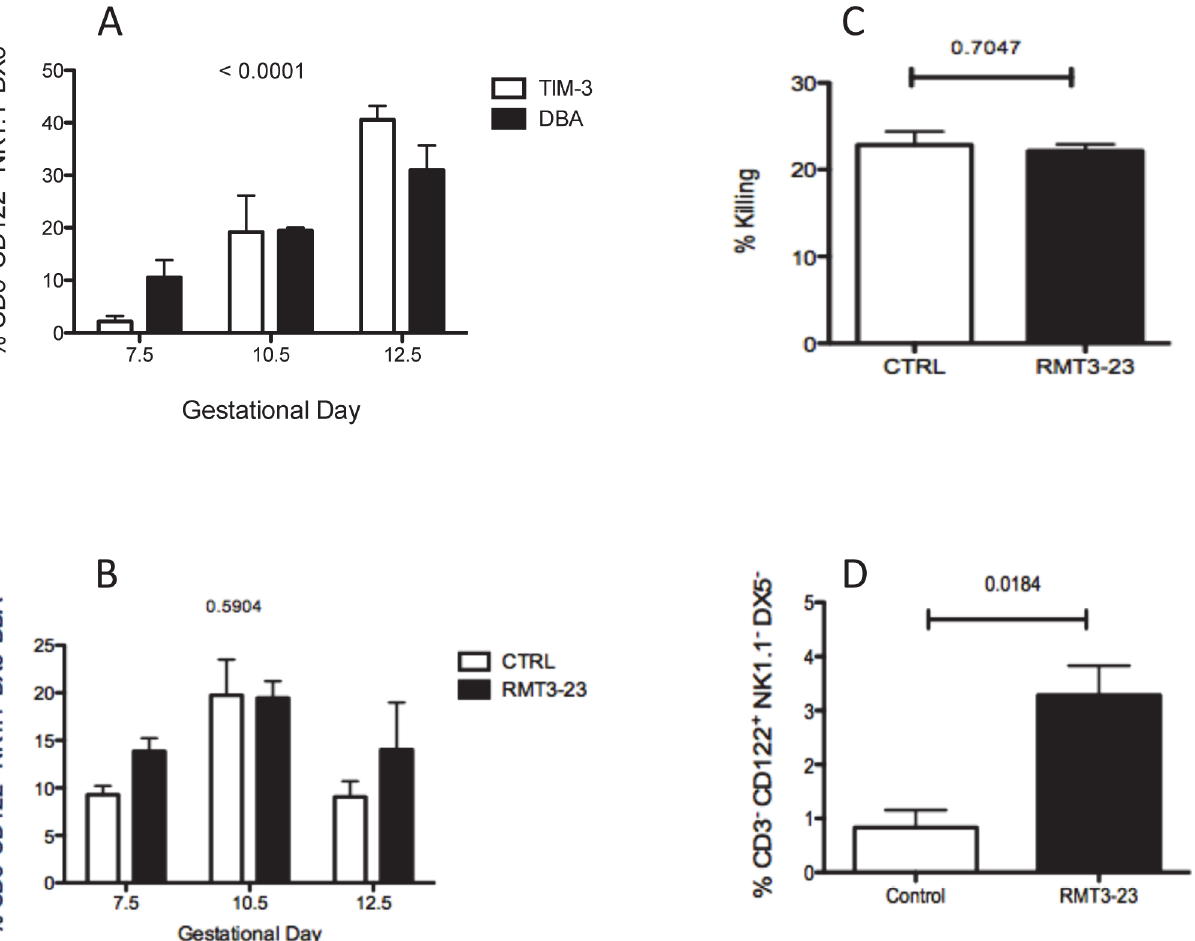
Fig 3. A. Expression of TIM-3 and DBA on uNK cells during gestation. A steady and similar increase in the expression of both TIM-3 and DBA is observed between GD 7.5 and 12.5, the time period when the uNK cells are most abundant in the uterus. TIM-3 and DBA expression were determined on the CD3 - CD122 + NK1.1 - DX5 - cells isolated from the uterus of pregnant CBA mice allogeneically mated with C57BL/6 males (n = 8). Data are presented as mean ± SEM and are representative of at least 3 experiments. Data show the percentage of CD3- CD122+ NK1.1- DX5- cells expressing DBA and TIM-3 on different GDs. Statistical analysis was performed using 2 way ANOVA. B. Effect of TIM-3 blockade on uNK cell population size. Percentage of CD3 - CD122 + NK1.1 - and DX5 - cell population in control and RMT3-23 treated pregnant CBA mice at GD 7.5, 10.5 and 12.5. There was no significant change in the number of uNK cells between control and treated groups. Data are presented as mean ± SEM and are representative of at least 3 experiments. Statistical analysis was done by one-way analysis of variance (ANOVA) using Kruskal-Wallis test. C. Effect of TIM-3 blockade on uNK cell cytotoxicity. No significant change was observed in the cytotoxicity of uNK cells following treatment with RMT3-23. Data are presented as mean ± SEM and are representative of at least 3 experiments. Statistical analysis was done using unpaired t test. D. Effect of TIM-3 blockade on Granzyme production by uNK cells. A small but significant increase in the production of Granzyme B was observed in the RMT3-23 treated uNK cells in comparison to control. Data are presented as mean ± SEM and are representative of at least 3 experiments. Statistical analysis was done using unpaired t